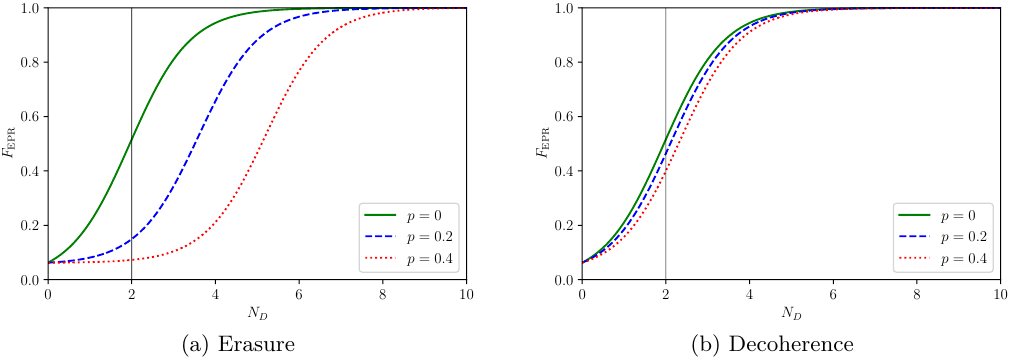
Figure 4 . N D (the size of late radiation) dependence of the decoding fidelity in the presence of (a) erasure errors and (b) decoherence. The sizes of total system and Alice’s state are fixed to be N = 10 and N A = 2 (black vertical line), respectively. The erasure errors have bigger impacts on the decoding fidelity/recoverability compared with the decoherence. Indeed, the decohrence has a small influence on the recoverability of the